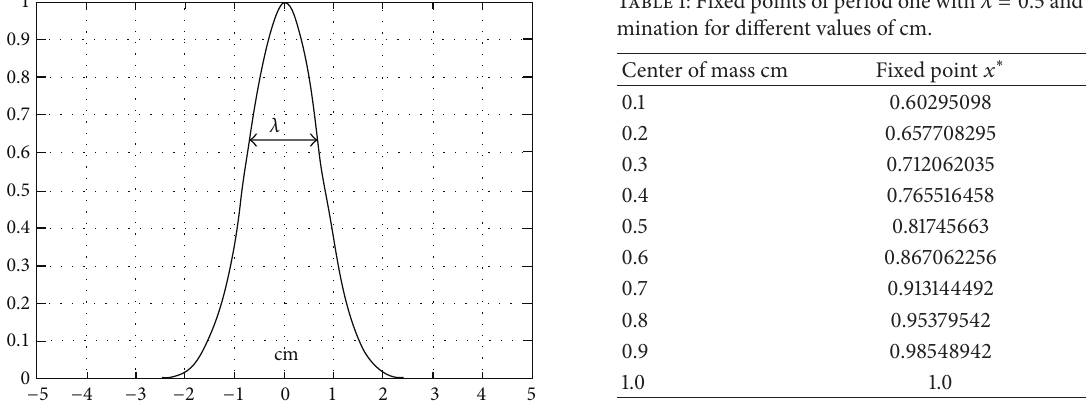
Figure 3: Gaussian bell. Its two parameters are displayed in the plot.